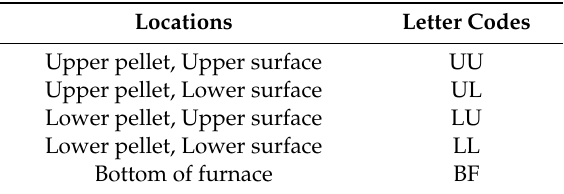
Table 2. Correspondence between positions and letter symbols in the